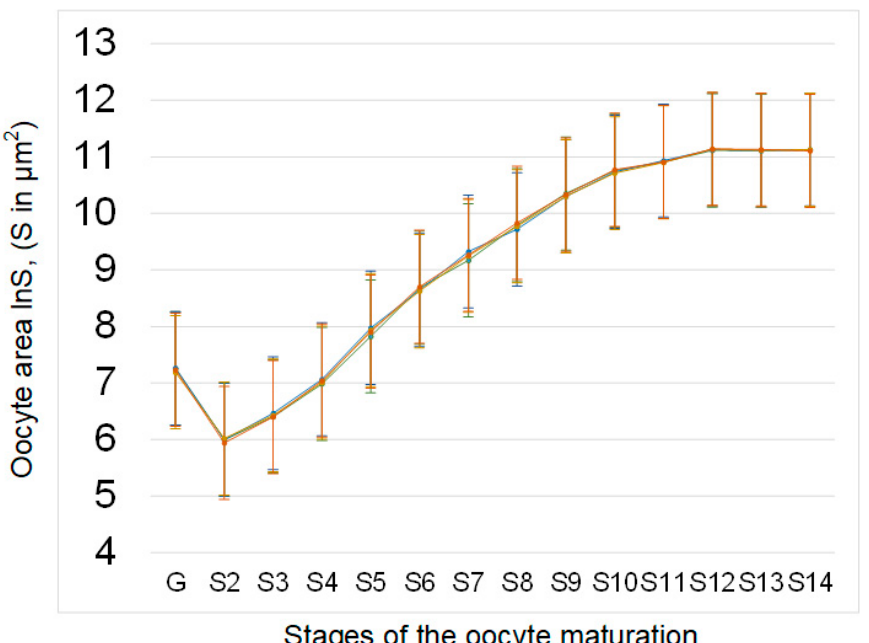
Figure 2. Area of oocytes at different stages of development in the ovaries of Drosophila melanogaster . The oocyte areas (measured in µ m 2 ; standard error for each value does not exceed 10%) are plotted on a logarithmic scale (lnS) due to the significant increase in values from early stages to mature oocytes. The color coding of the groups is the same as above (C—green, s µ g—blue; C + E—yellow; s µ g + E—red). There were no significant differences in the square of oocytes at different stages between the experimental groups.